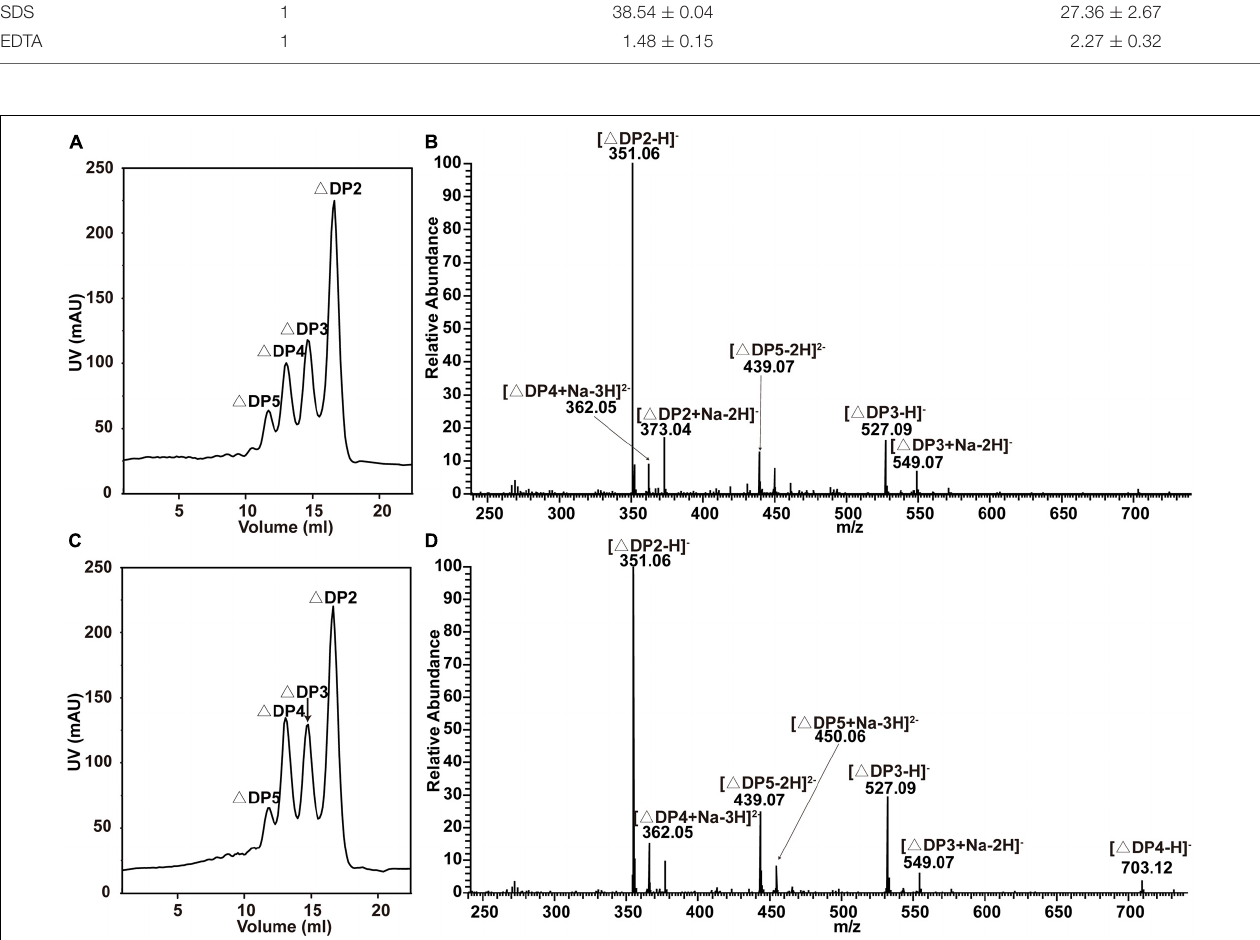
FIGURE 3 | End products of alginate degradation by recombinant VxAly7B-FL and VxAly7B-CM. (A,B) End products of recombinant VxAly7B-FL analyzed by gel filtration chromatography and negative ion ESI-MS. (C,D) End products of recombinant VxAly7B-CM. Elution volumes were 16.10 mL for unsaturated disaccharides ( (cid:49) DP2), 14.90 mL for unsaturated trisaccharides ( (cid:49) DP3), 14.10 mL for unsaturated tetrasaccharides ( (cid:49) DP4), and 13.44 mL for unsaturated pentasaccharides ( (cid:49) DP5).